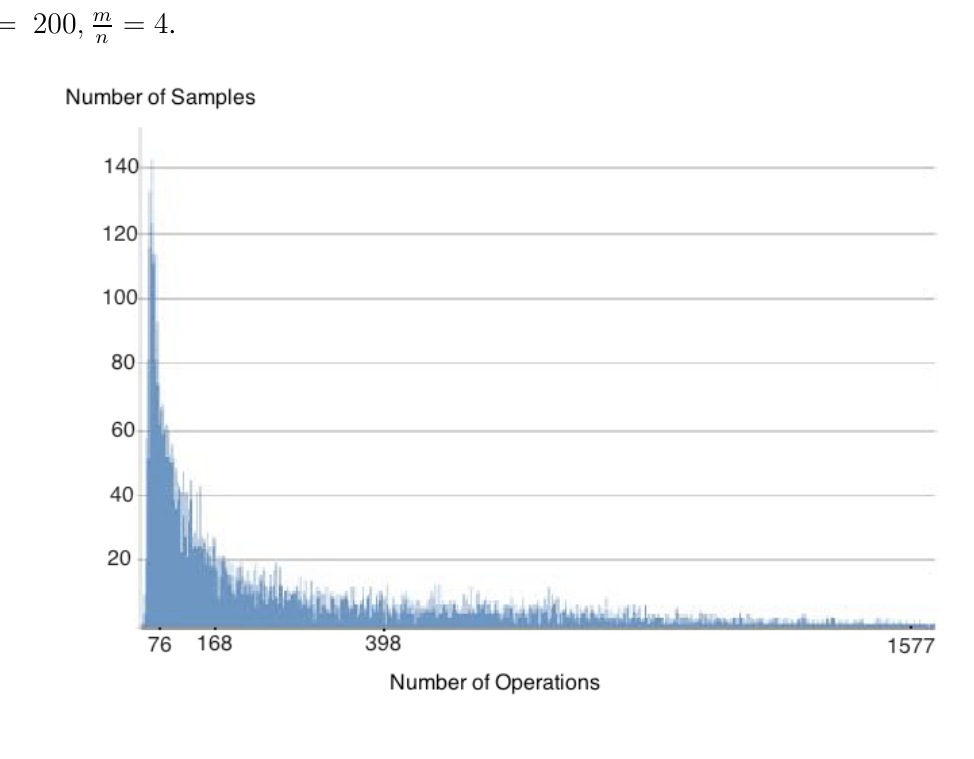
Distribution at the output of zChaff running problems with n = 50 and = 4 . m = 200 , m n